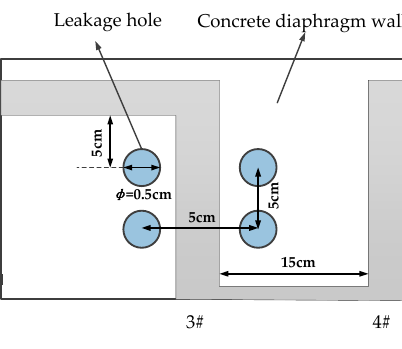
Figure 5. Layout of leakage Figure 5 . Layout of leakage holes. Figure 5 . Layout of leakage holes.